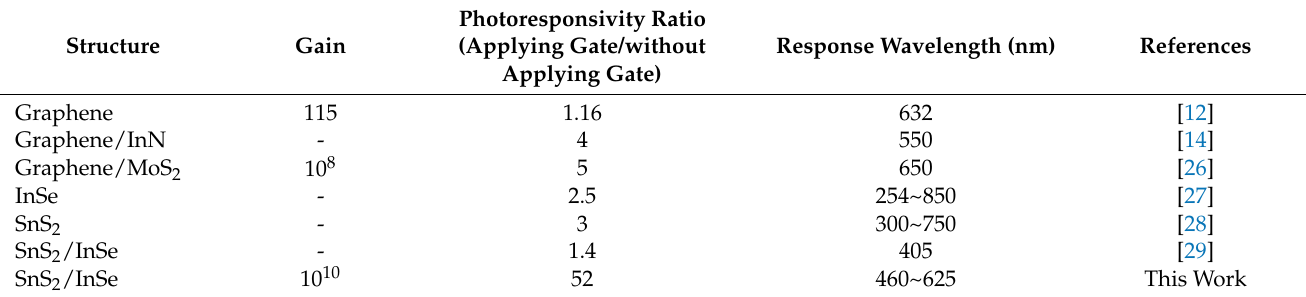
Table 1. Comparison of gate effect on 2D photodetectors.